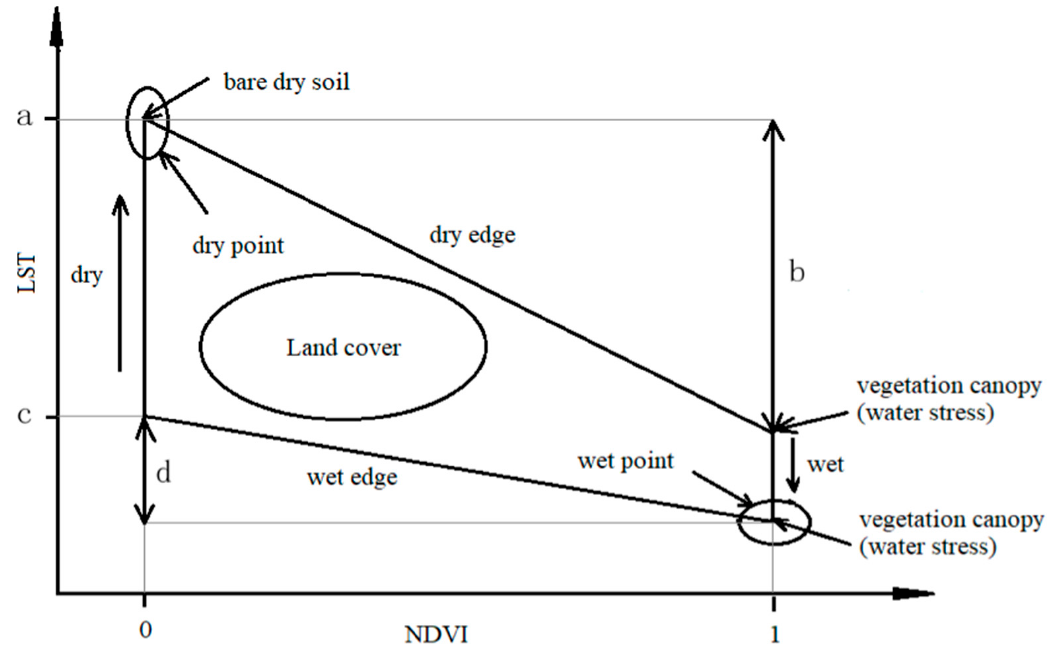
Figure 2. Sketch illustrating parameters of the traditional Thermal-optical Trapezoid model [39]. The values of the four typical drought indexes range of 0 and 1; the larger the TVDI values, the more arid the region, while smaller values of the other three indexes represent